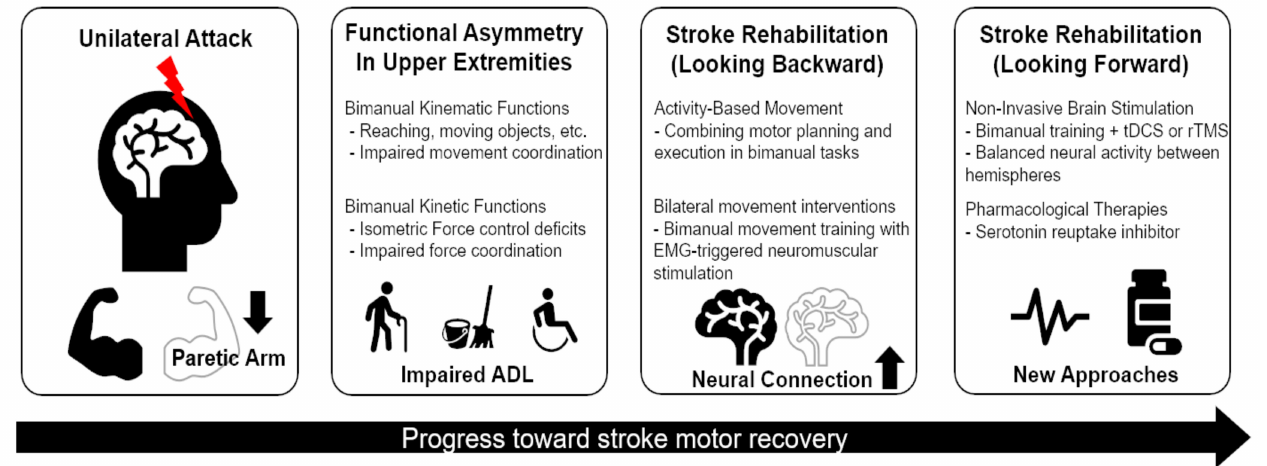
Figure 1. Progress toward stroke motor recovery using bimanual motor